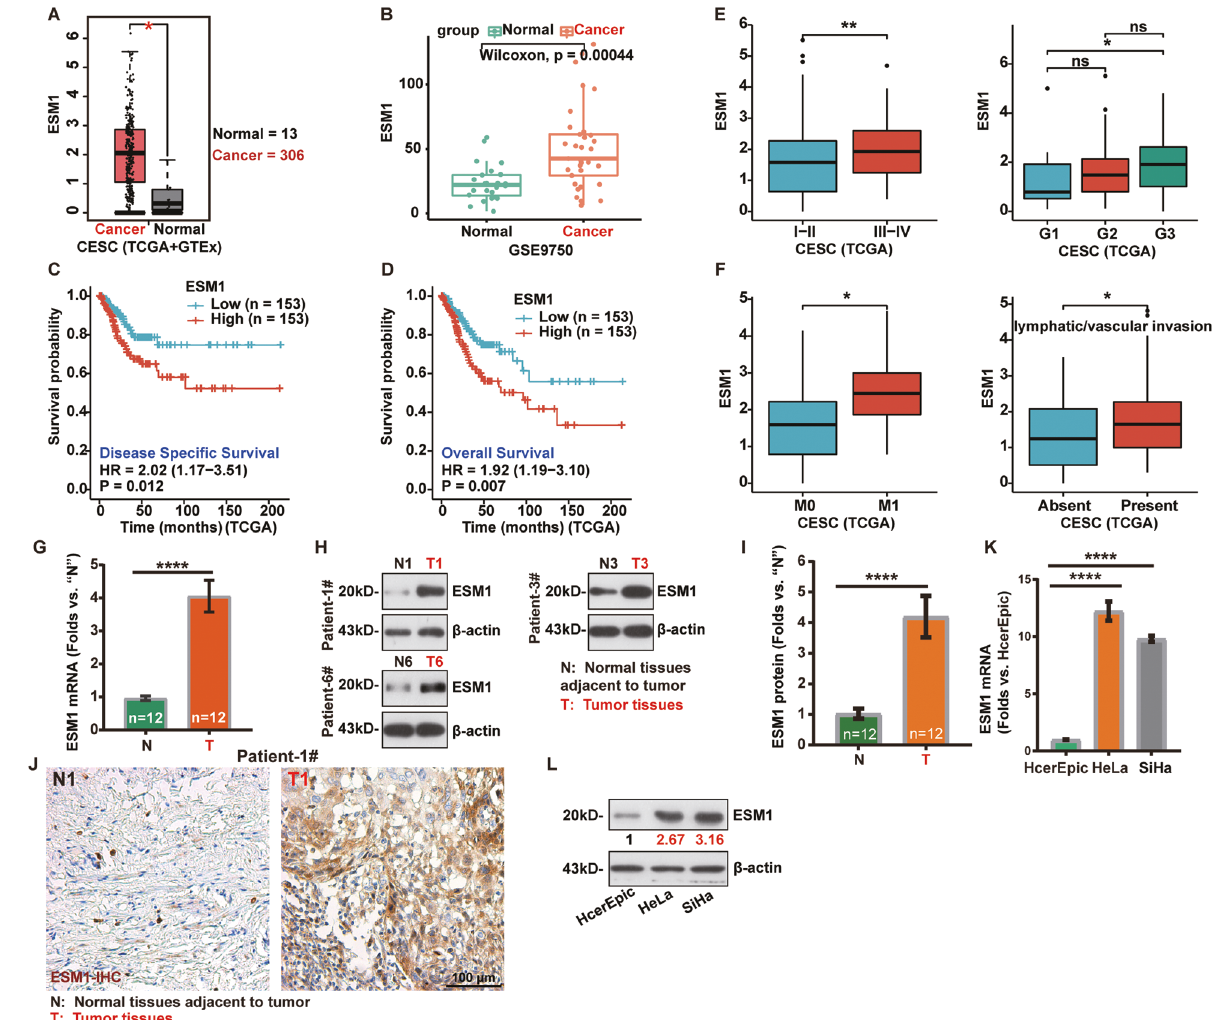
Fig. 1 ESM1 is upregulated in human cervical cancer. The mRNA transcripts of ESM1 in cervical cancer ( n = 306) tissues compared with normal tissues ( n = 13) in TCGA database ( A ) and GEO database ( B ) were shown. Disease-speci fi c survival ( C ) and overall survival ( D ) in cervical cancer patients with different expression levels of ESM1 were shown. Subgroup analysis, based on the different clinical characteristics of the cervical cancer patients in TCGA, was conducted ( E, F ). ESM1 mRNA ( G ) and protein expression ( H and I ) in twelve ( n = 12) pairs of cervical cancertumor tissues ( “ T ” ) and adjacent normal tissues ( “ N ” ) were tested by qRT-PCR and Western blotting assays. Immunohistochemical staining was used to test the expression of ESM1 in Patient-1# ’ s tissue ( J ). ESM1 mRNA ( K ) and protein ( L ) expression in the listed cervical cancer cells and the cervical epithelial cell was tested by qRT-PCR and Western blotting assays. The data were presented as mean ± standard deviation (SD). * P < 0.05, ** P < 0.01, *** P < 0.001, **** P < 0.0001. Scale bar = 100 μ m ( J ).